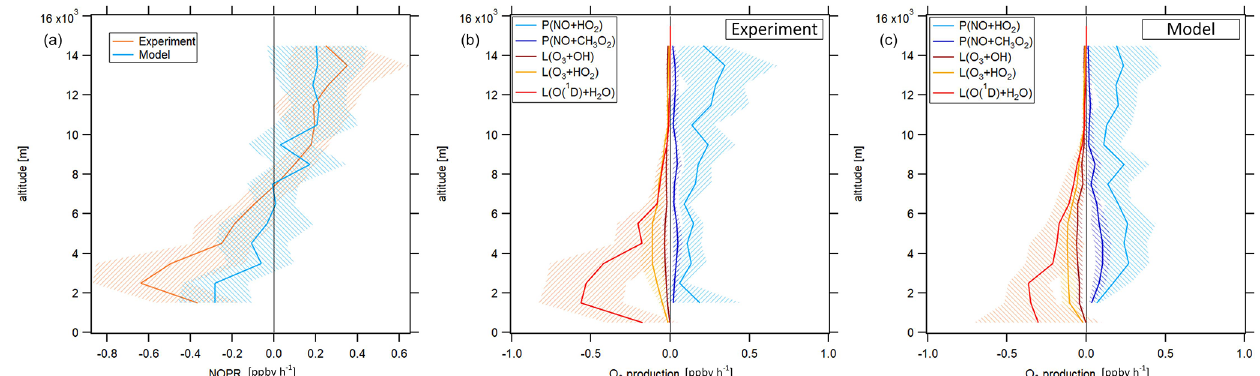
Figure 5. Vertical profile of tropospheric NOPRs calculated based on Eq. (6) during CAFE-Africa (a) . The orange and blue lines represent NOPR calculations based on measured and simulated data, respectively. Panels (b, c) show the components of net ozone production in Eq. (6) derived from experimental data (b) and simulated data (c) . The figures have been filtered for stratospheric measurements by removing data points for which O 3 exceeds